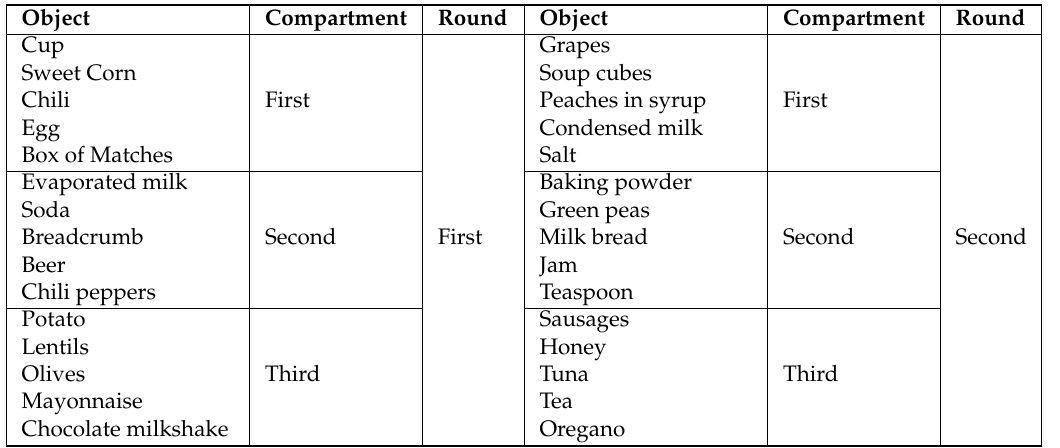
Table 2. Order of objects in the experimentation with the smart